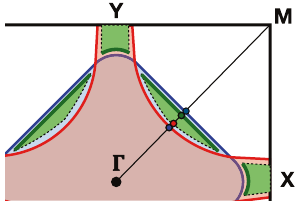
Fig. 3 Coexisting Luttinger surface and Fermi pockets. Fermi pockets, in green, which arise when the equation ϵ ( k ) ϵ * ( k ) = − Δ 2 admits real roots. The dots along the Γ → M direction are the points at which we calculate the single-particle DOS in Fig. 4. The bold green arcs along the Fermi pockets boundaries are the positions in k -space of the highest zero-energy peaks in the physical electron DOS.